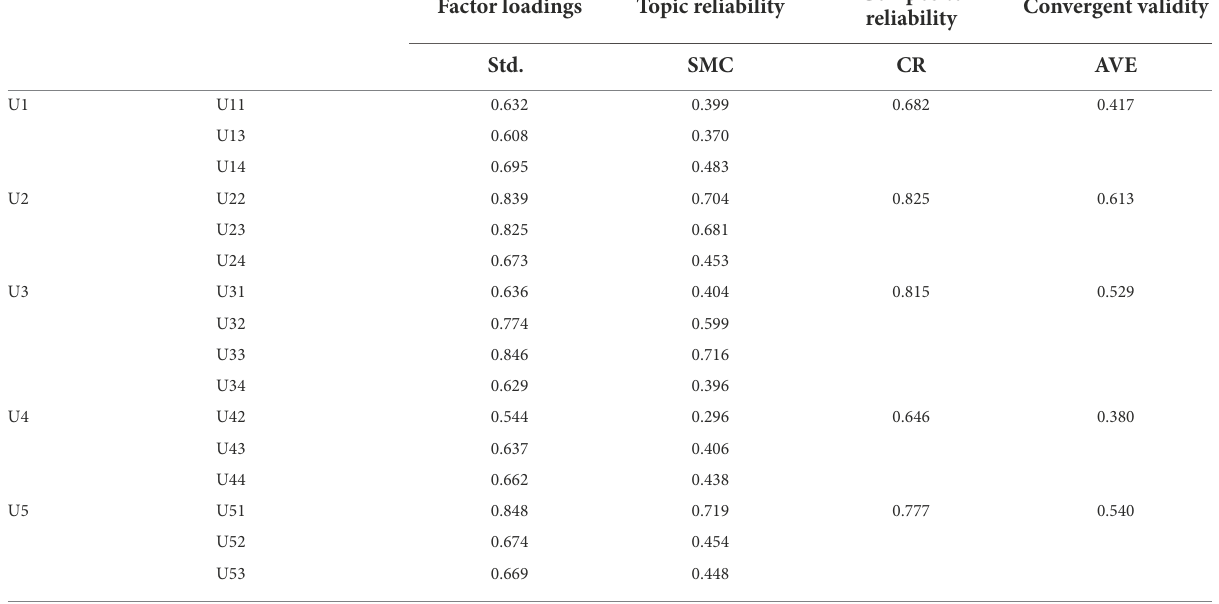
TABLE 2 Confirmatory factor analysis.